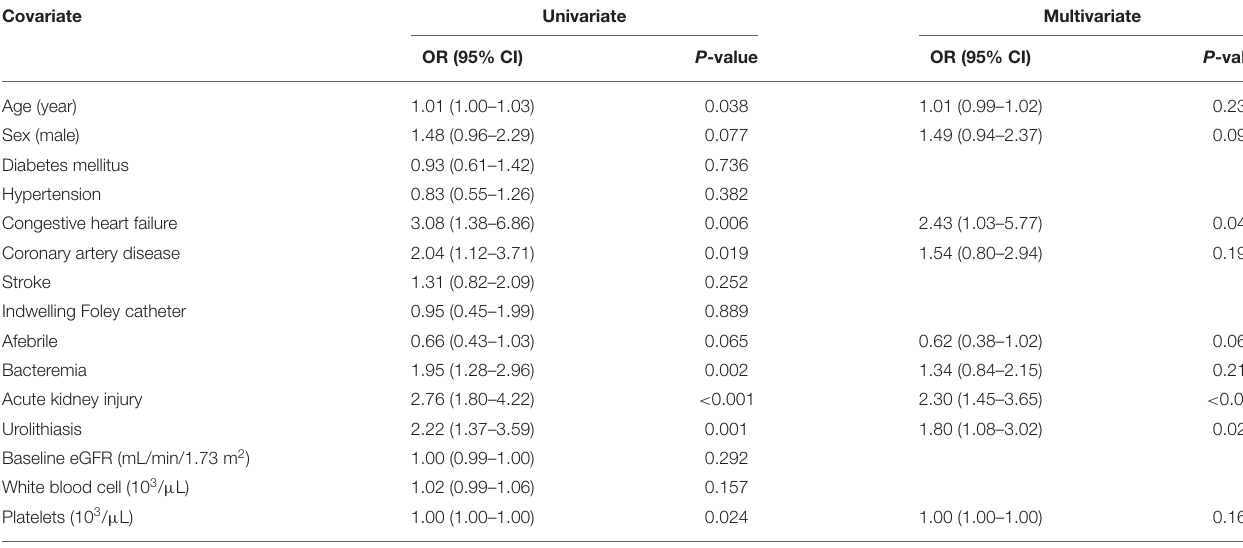
TABLE 2 | Univariate and multivariate logistic regression analyses of factors related to uroseptic shock in patients with urinary tract infection. Covariate Univariate Multivariate